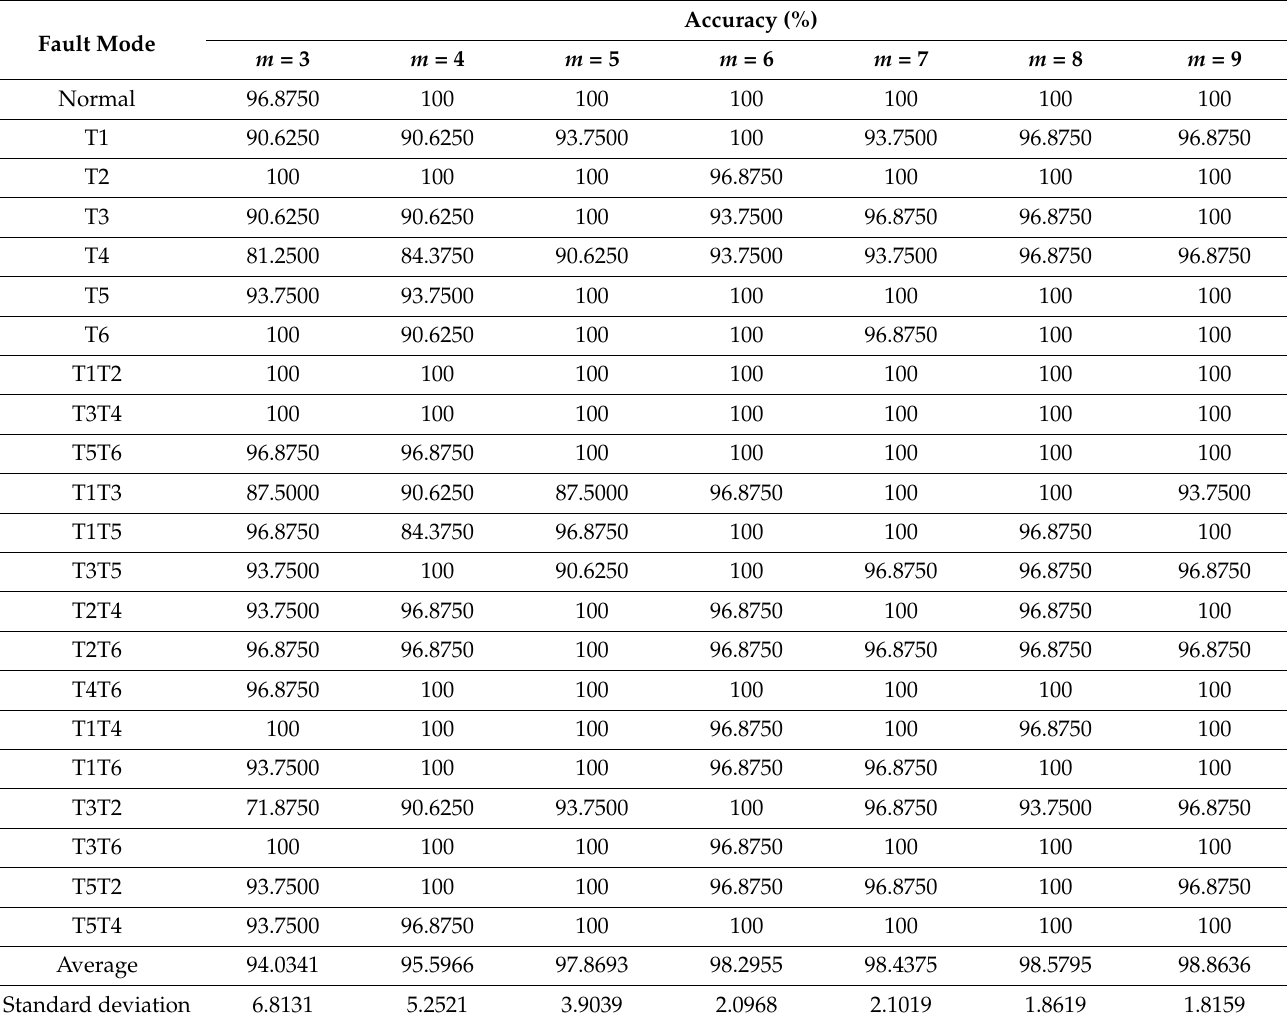
Table 4. The diagnosis results of 22